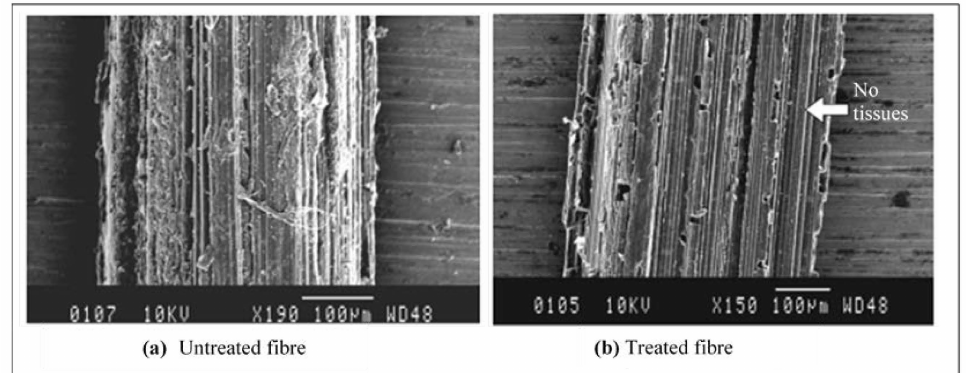
Figure 1. ( a ) Untreated and ( b ) treated fibre